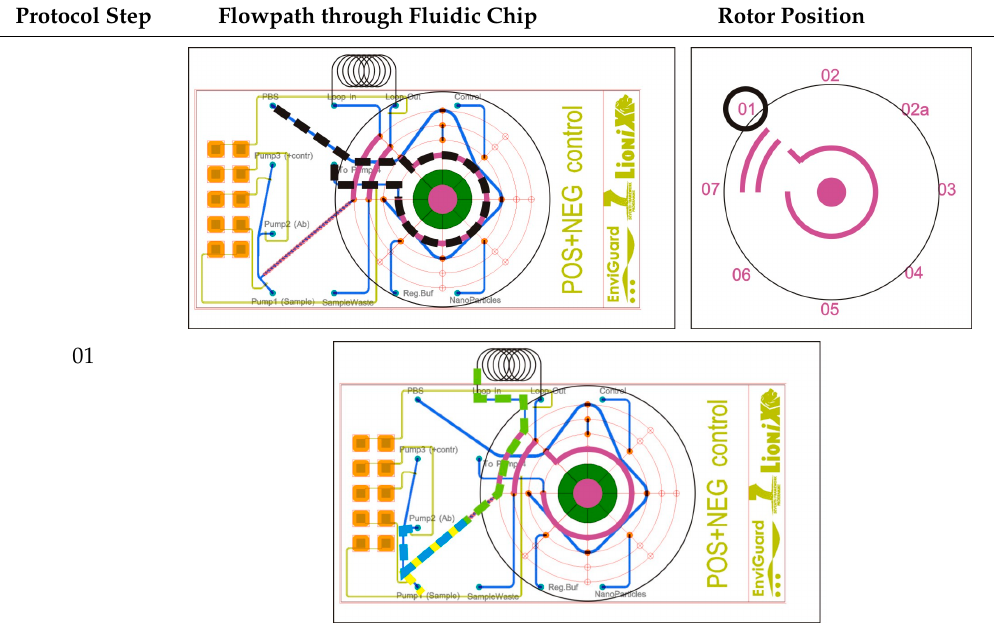
Table A1. Flow paths in the fluidic chip for each position of the multivalve.